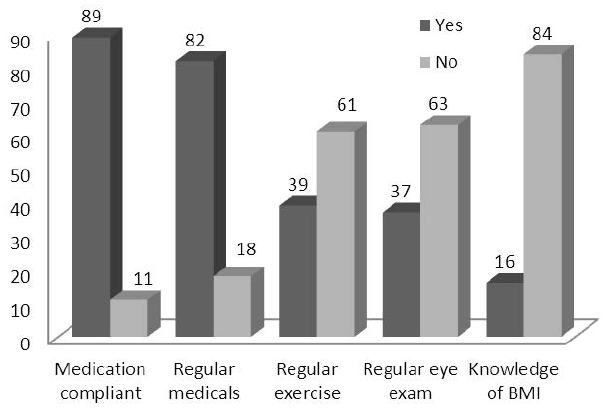
Figure 5: Percentage of respondents knowledge and practices of different areas of DM